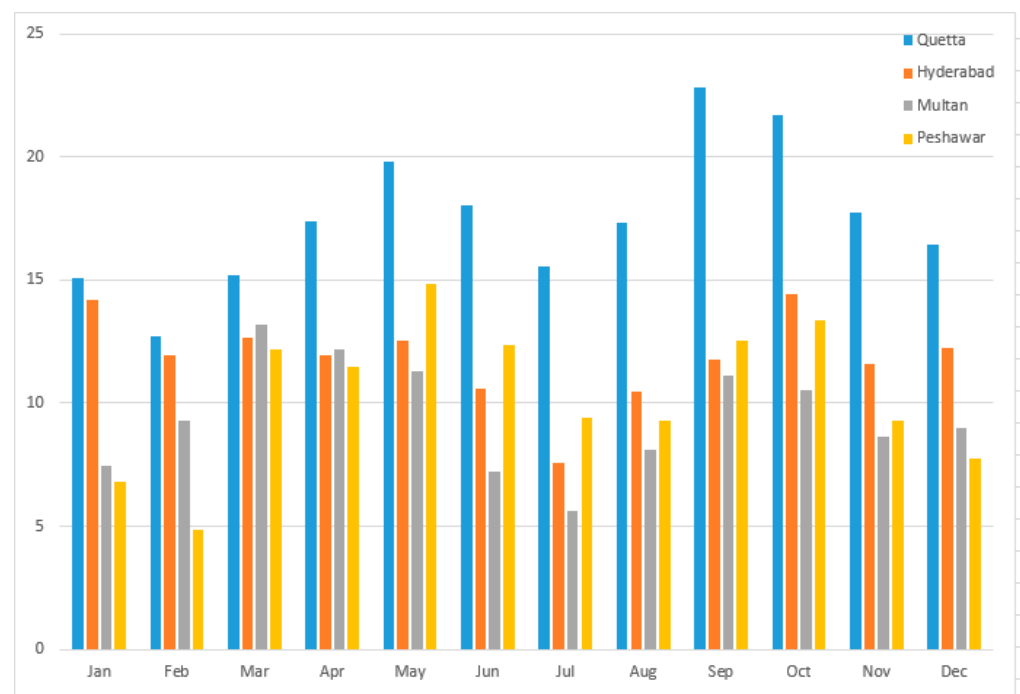
Figure 17. Electricity production by the 50 MWe SPT plant with dry cooling for different regions. Table 9. Performance parameters of the 50 MWe SPT plant with air cooling.